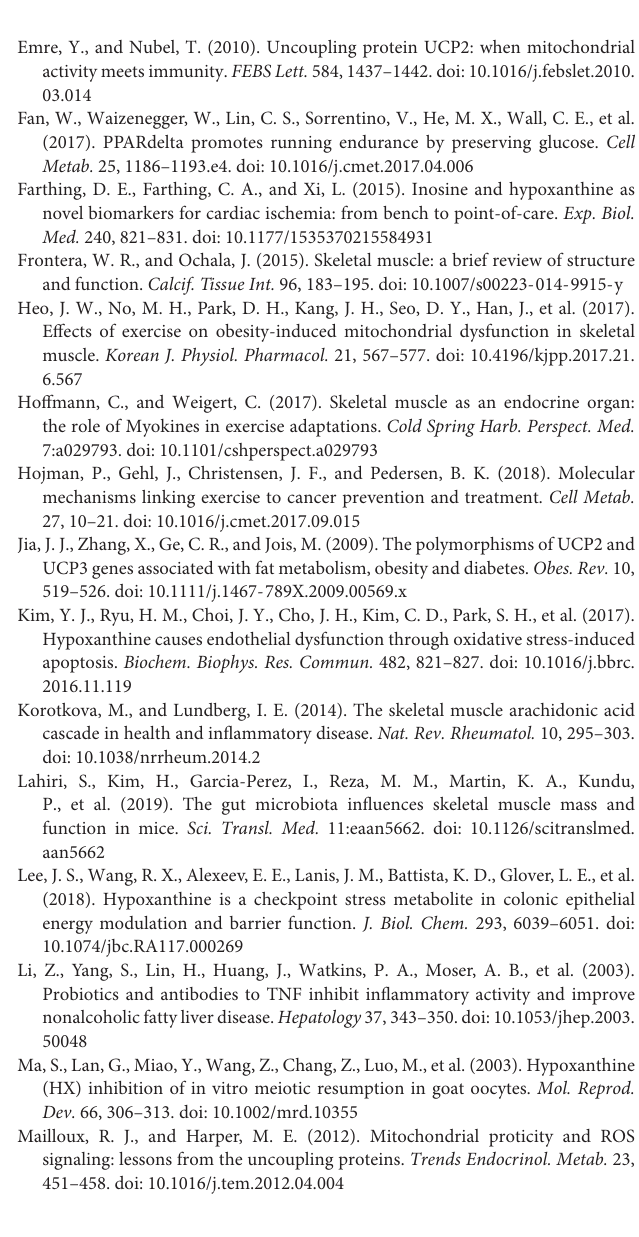
Supplementary Figure 1 | Locomotor activity (bean breaks) of mice after 4 weeks Hx treatment ( n = 8 mice per group). Values are presented as means ± SEM. Supplementary Figure 2 | (A–C) Serum AST (A) , ALT (B) , and BUN (C) levels after acute Hx treatment ( n = 8 mice per group). Values are presented as means ± SEM. Supplementary Figure 3 | (A) ROS level in the GAS muscle ( n = 8 mice per group). (B) mRNA expression of Gss and Gpx4 in the GAS muscle ( n = 8 mice per group). β -actin was used as loading control in the qRT-PCR. Values are presented as means ± SEM; ∗ P ≤ 0.05 according to non-paired Student’s t -test between individual groups. Supplementary Figure 4 | Body weight (A) and body composition (B) of AAV injection mice before acute Hx treatment ( n = 8 mice per group). Values are presented as means ±